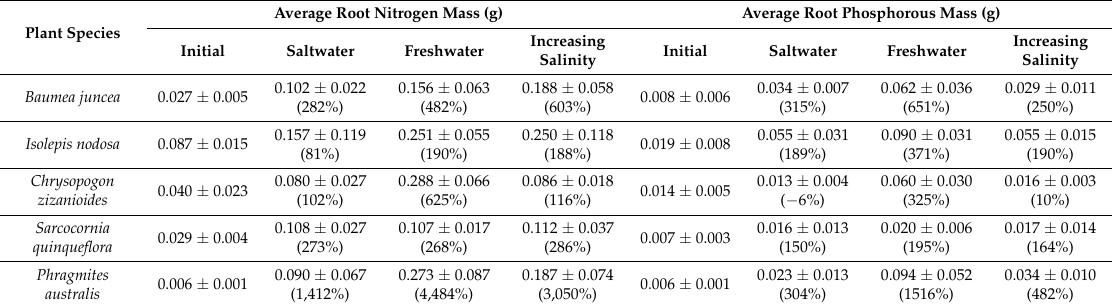
Table 4. Initial Tubestock Root Nutrient Mass and Final Root Nutrient Mass for Each Species in Each Water Treatment (Percentage Change in Root Nutrient Mass Shown in